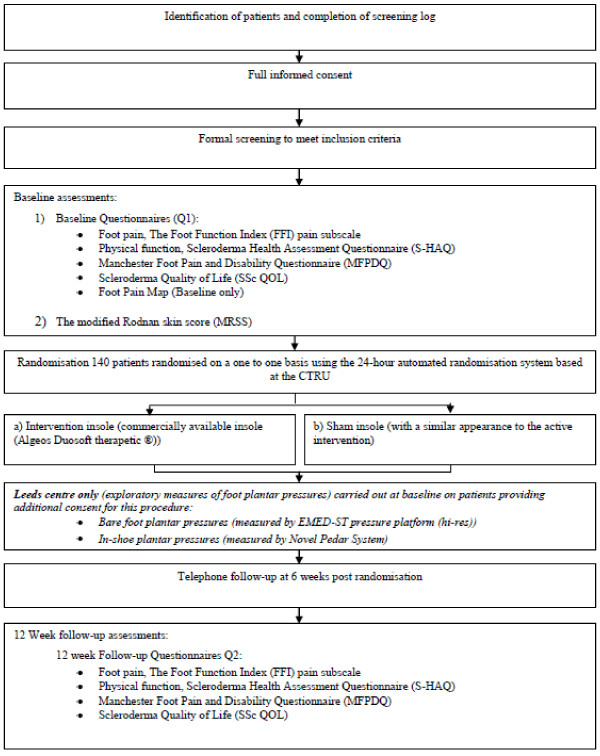
Trial flow diagram.